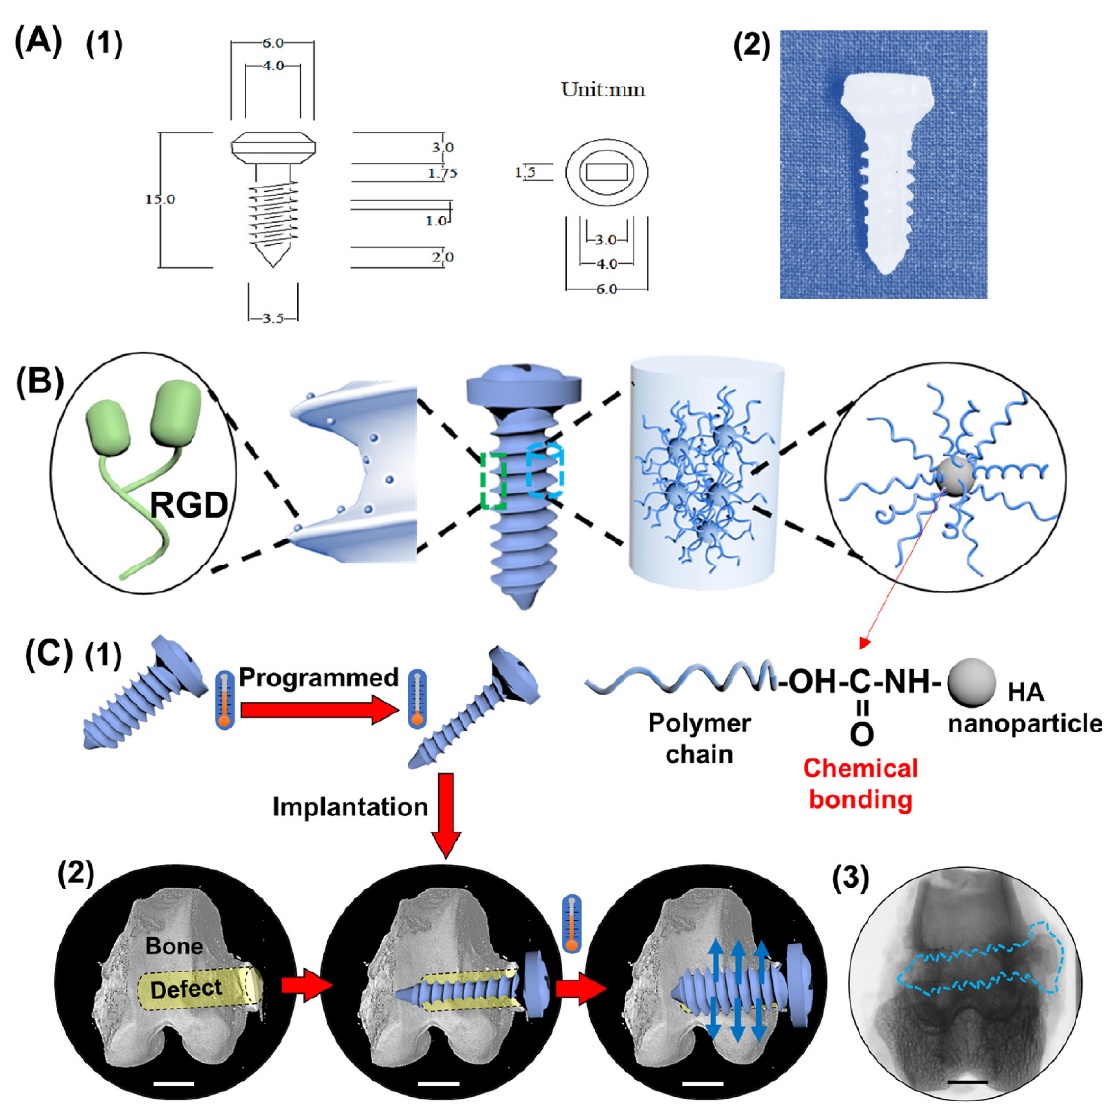
Figure 3. Robust shape memory polymer composite screws made of SMPU/HA/arginylglycylaspartate (RGD) are temperature-responsive to address the stiffness, bioactivity, and internal fixation capabilities of conventional screws limitations. The working schematic diagram of a SMPC screw: ( A ) size (1) and prototype (2) of the bone screw; ( B ) components in the SMPC screw; ( C ) working principle of a memory screw: (1) the screw was compressed at high temperature and then fixed at low temperature; (2) the programmed screw was implanted into the bone defect site by minimally invasive surgery; due to SME, the screw recovered to its original state and offered a supporting effect to the surrounding tissues; blue arrow: recovery force. The scale bars are 5 mm. (3) Representation of a single-slice micro–computed tomography (micro-CT) image after 12 weeks of implantation; blue imaginary line area indicates the SMPC screw. (Reproduced with permission [137]. Copyright 2020,